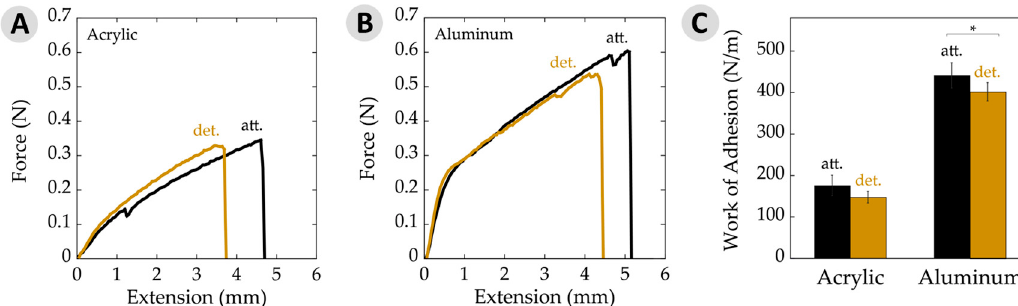
Figure 5. Work of adhesion data per unit area. ( A ) Typical force–extension curves on acrylic for attached (att.) and detached (det.) samples. Curves represent average plaque area, force, and extension values seen on acrylic. ( B ) Typical force–extension curves on aluminum substrates for attached and detached samples. Curves represent average plaque area, force, and extension values seen on aluminum. ( C ) Work of adhesion per unit area showing attached and detached values on acrylic and aluminum substrates. The asterisk (*) indicates a statistically significant difference ( p ≤ 0.05). Error bars depict 95% confidence intervals.